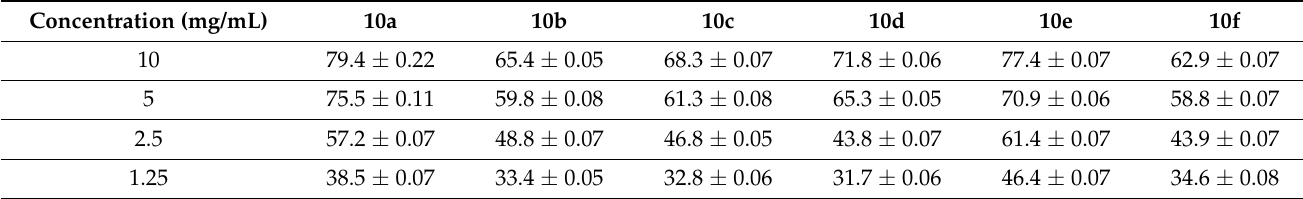
Table 7. Anti-biofilm assay of conjugate 10 towards MRSA ATCC 43300. Experiment evaluated based on quadruplicate results with standard deviation. (n = 4).